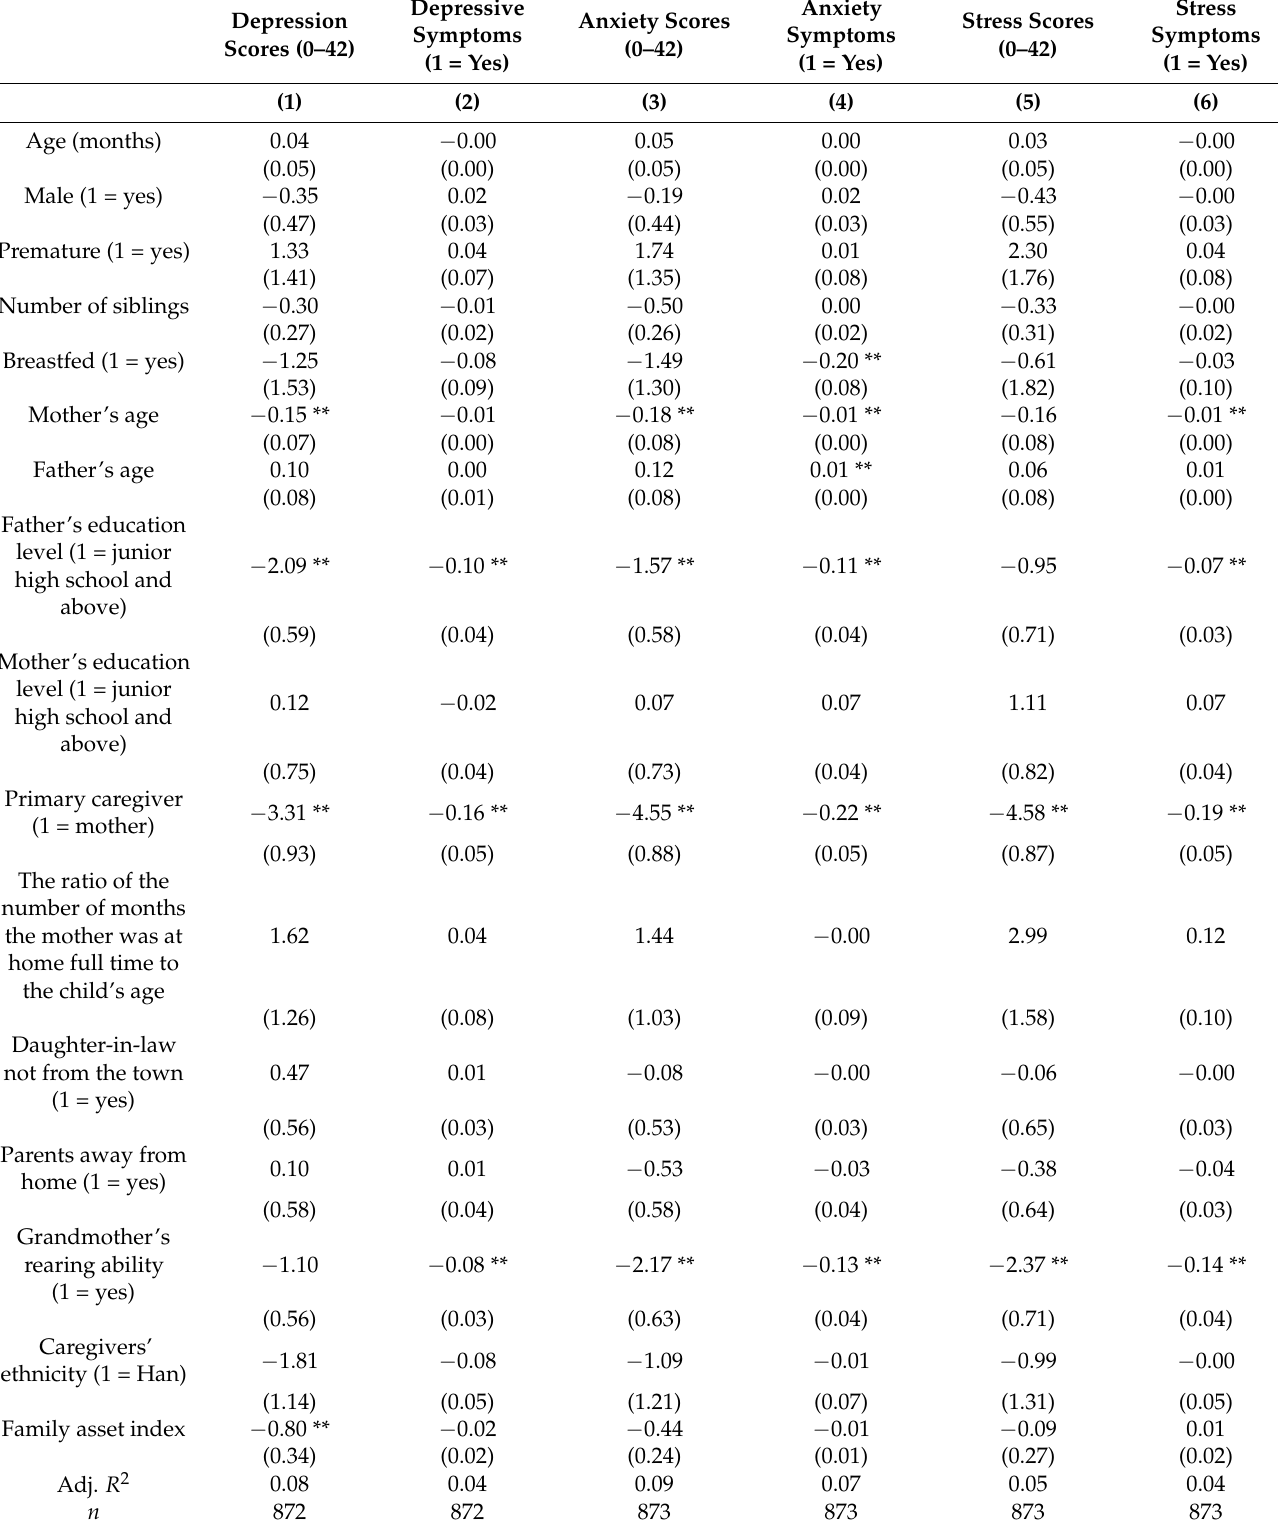
Table 3. Female caregivers’ mental health outcomes with the children and family